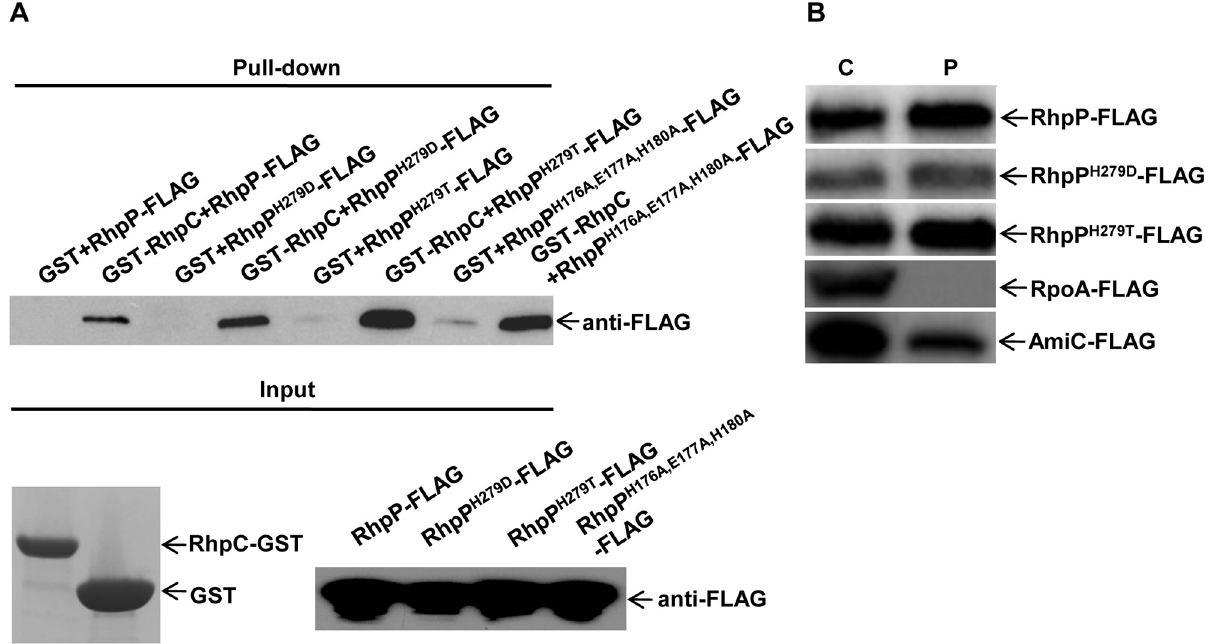
Fig 8. Mutants of RhpP active sites retained interaction with RhpC and translocation to periplasm. (A) Interaction of RhpC with RhpP mutants. RhpP and RhpP mutants of the active sites (RhpP H279D , RhpP H279T , and RhpP H176A,E177A,H180A ) were tagged with FLAG and expressed in the wild type Psph strain using pHM1 plasmid. The purified proteins were incubated with the purified GST or GST-RhpC on the glutathione sepharose beads and then precipitated by centrifugation. Protein pulled down by the beads were assayed using Western blot with anti-FLAG antibody. (B) Translocation of RhpP mutants. RhpP and RhpP mutants of the active sites (RhpP H279D , RhpP H279T ) were tagged with FLAG and expressed in the wild type Psph strain using the pHM1 plasmid. Proteins in the periplasm and cytoplasm were examined using Western blot with anti-FLAG antibody. Cytoplasmic protein RpoA and periplasmic protein AmiC were used as protein fractionation control. C, cytoplasmic protein; P, periplasmic protein.